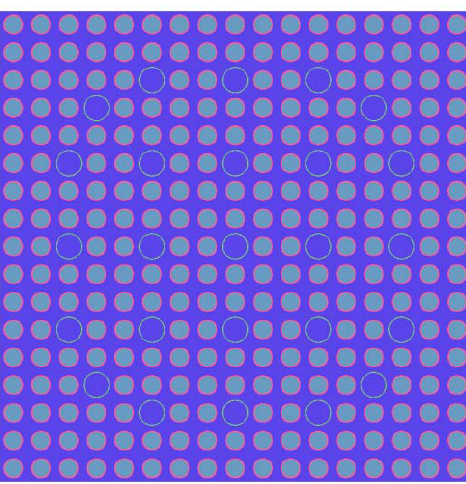
Figure 3. The sketch of the PWR